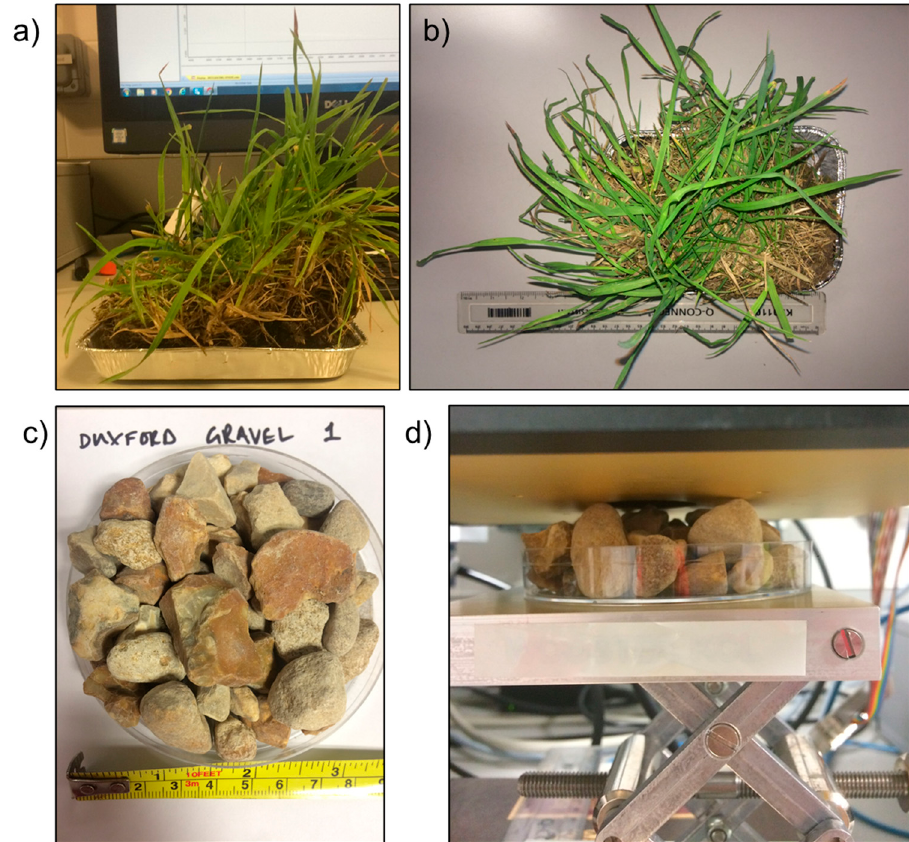
Figure 8. Laboratory preparation of ( a ) the grass sample from Alconbury from the side and ( b ) from above, ( c ) the gravel sample from Duxford from above, and ( d ) underneath the sample port of the external integrating sphere.